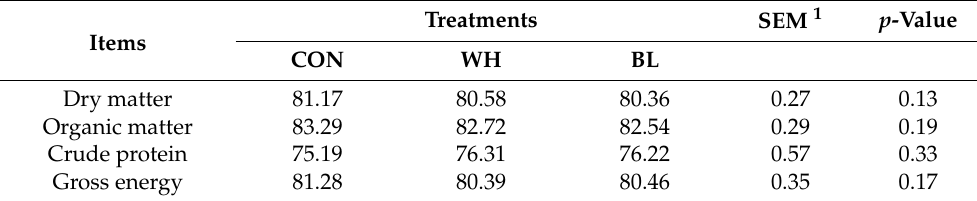
Table 4. Effects of partial substitution of corn by wheat or barley on apparent digestibility of total Intestinal Nutrients in growing pigs (%).